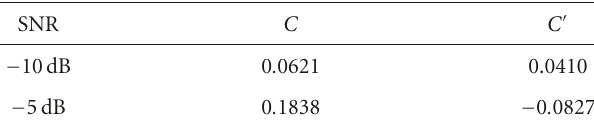
Figure 6: Comparison of capacity versus actual SNR for di ff erent SISO channels.